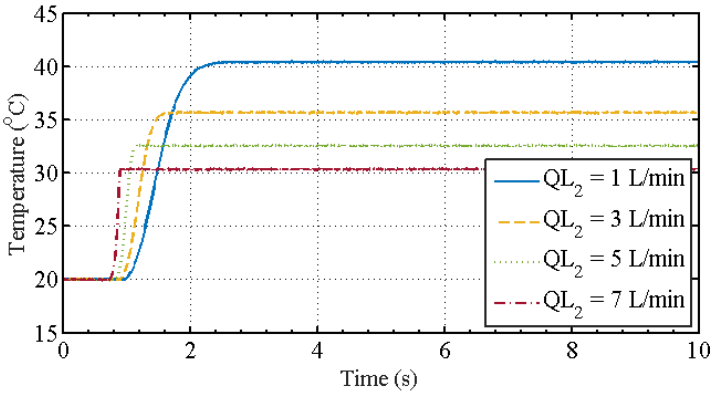
Figure 25. The output temperature in cold fluid with QL 1 = 7